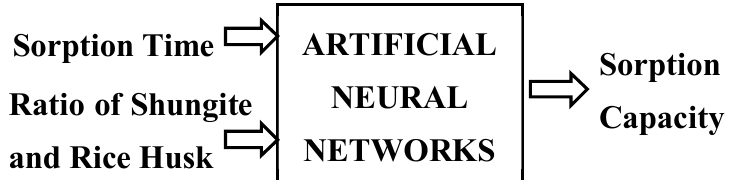
Figure 3. Structure of the ANN model for sorption capacity prediction.